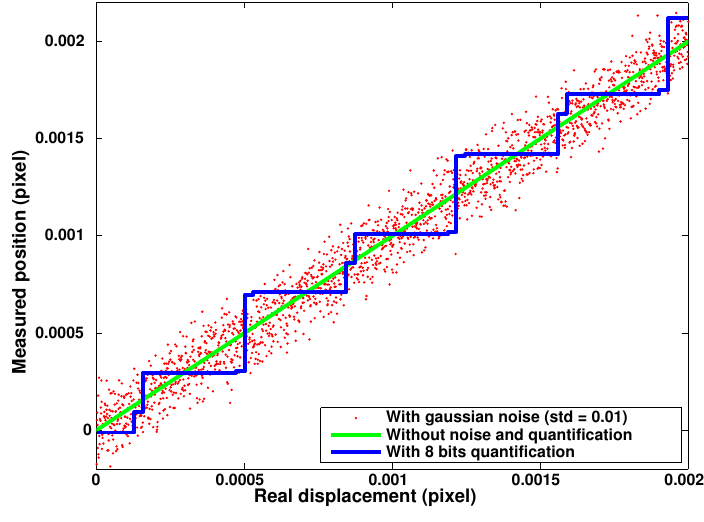
Figure 7. Simulated position reconstruction as a function of numeric noise (green), signal quantization (blue) and presence of noise (red); period of 51.123 pixels, computation step of 10 − 6